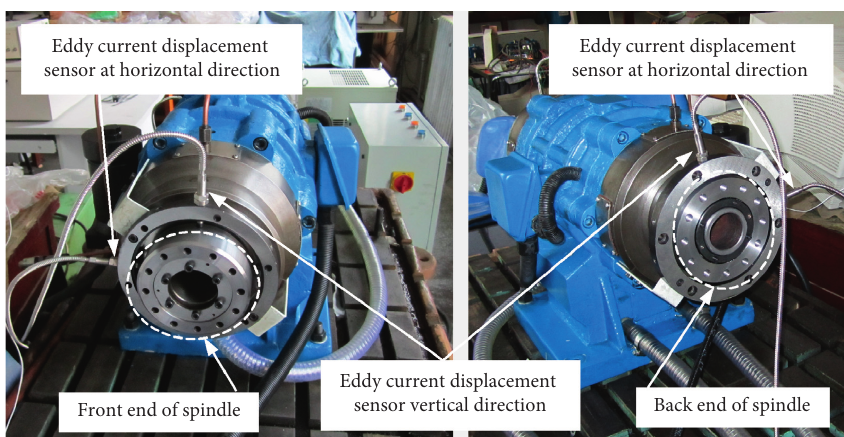
Figure 6: Layout of eddy current displacement sensors at the front and back ends of the